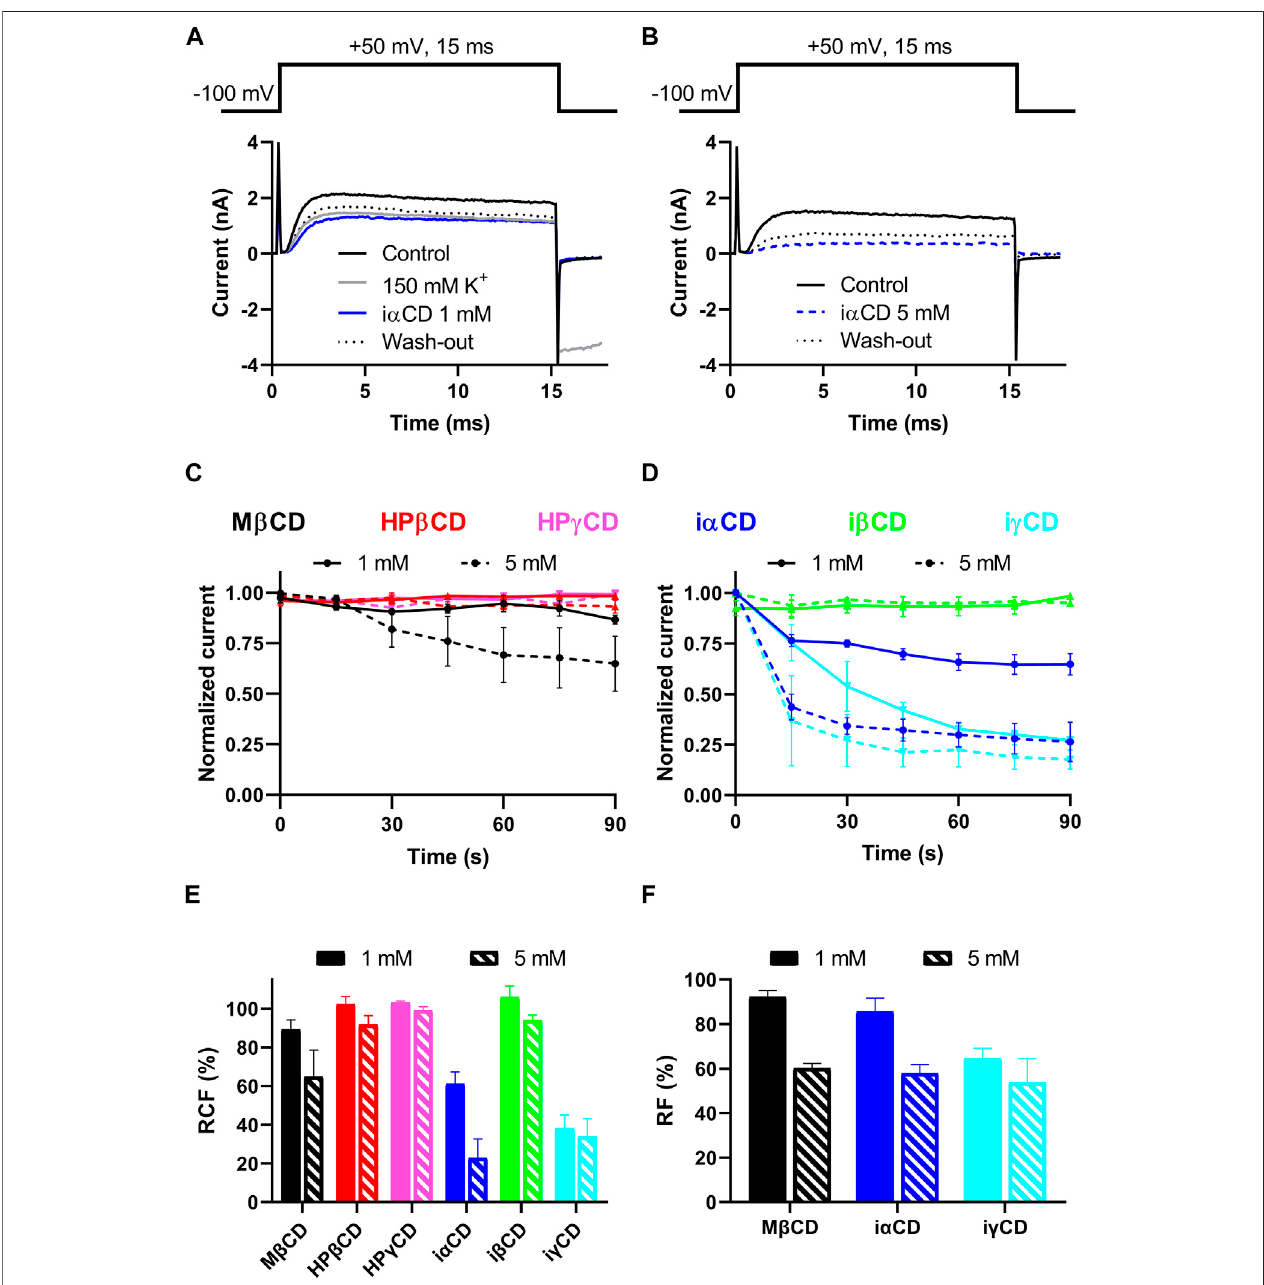
FIGURE2| EffectsofCDsonK V 1.3current. (A,B) Patch-clampmeasurementswereperformedinoutside-outorwhole-cellcon fi gurationsinCHOcellstransiently expressing K V 1.3. Two representative measurements with the application of 1mM (panel A) and 5mM (panel B) i α CD are shown. K + currents were elicited by applying 15ms-long depolarizing pulses from − 100mV to +50mV every 15s (panels A and B, top). First, cells were perfused with standard extracellular solution to obtain control currents( I 0 ,panels Aand B, black solid lines). Tovalidate proper workingofthe perfusion systeman extracellularsolutionwith 150mM K + wasapplied foreach cell prior to CD exposures (panel A, grey line). Cells were perfused with CD-containing extracellular solutions for a maximal application time of 3min to avoid cholesterol- extracting effects ofCDs (panels A and Bblue lines). Then the reversibility ofcurrent-blocking effectsinduced bythecompounds wasdeterminedby thereapplicationof standard extracellular solution (panel A and B black dotted lines). (C,D) To demonstrate the wash-in kinetics of CDs, leak-corrected peak currents at every time point were normalized to the maximal peak. Among cholesterol-depleting CDs, only M β CD in 5mM exhibited a current block (Panel C, black dashed line), while among the non-cholesterol depleting inverted CDs, i α CD (panel D, blue lines)and i γ CD(panel D, cyan lines) showed similar effects at both 1mM (solid lines) and 5mM (dashed lines) concentrations. The current blocking effectswere saturated within 90s after the initiation of CD exposurein all cases. (E) To quantify current-inhibiting effects, remaining currentfraction(RCF)valueswerecalculatedaccordingtoequation(DavisandBrewster,2004).Theef fi cacyorderoftheinducedcurrentblockwasM β CD < i α CD < i γ CD in both concentrations. (F) To characterize the extent of wash-out, recovered current fractions (RF) were determined according to equation (Uekama, 2004). This analysis showed that the current block induced by CDs was only partially reversible. Data represented as mean ± SEM based on n (cid:1) 4 – 6 cells.